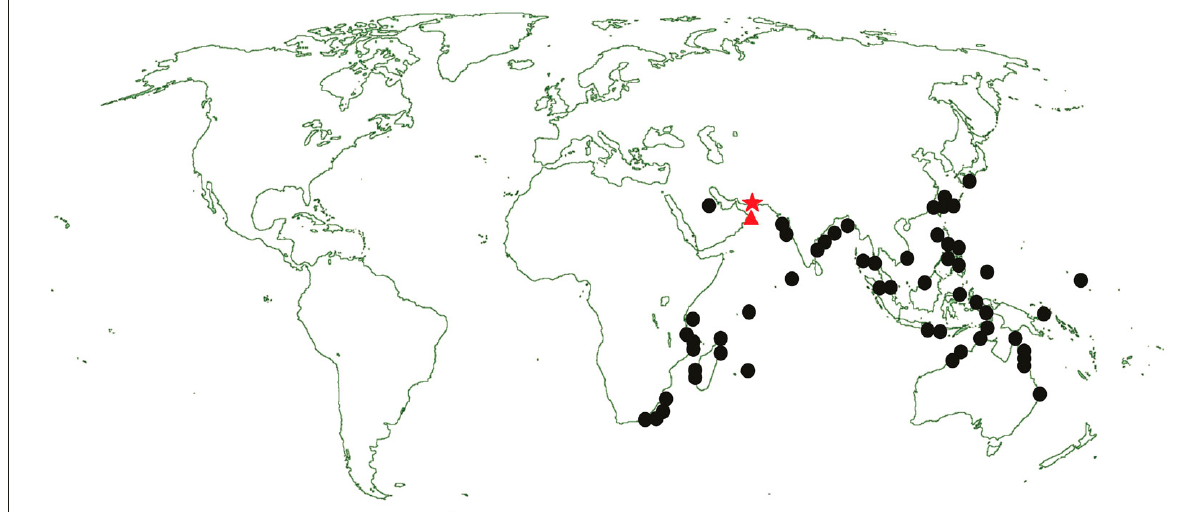
Figure 4. World distribution map of F. reichei , including new record (red star) and previous record from Oman coastal area (red triangle).